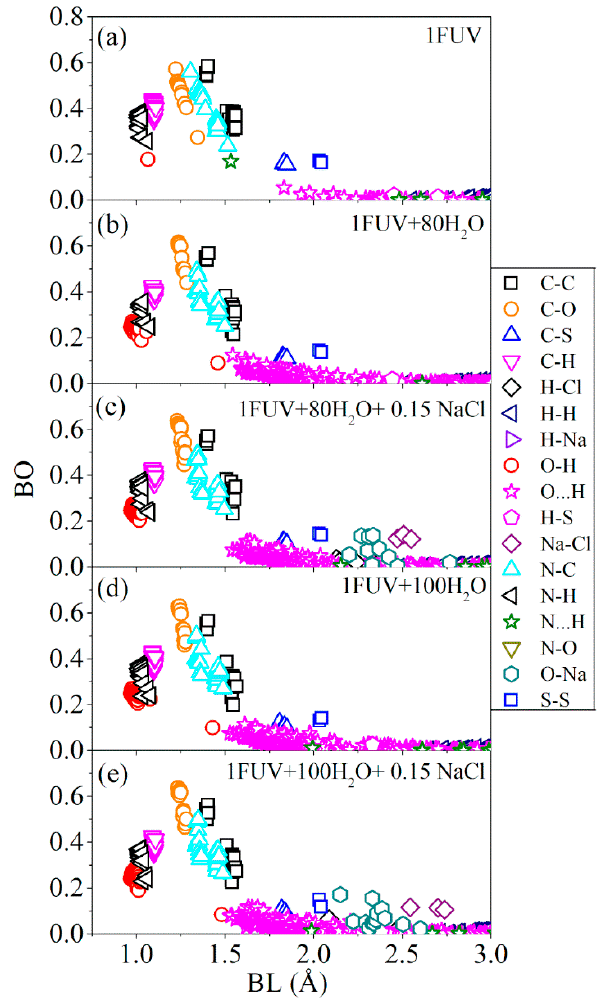
Figure 3. Distribution of BO vs. BL in the three 1FUV models: ( a ) dry 1FUV; ( b ) 1FUV with 80 H 2 O, ( c ) 1FUV with 80 H 2 O and 0.15 NaCl; ( d ). 1FUV with 100 H 2 O, and ( e ) 1FUV with 100 H 2 O and 0.15 NaCl.